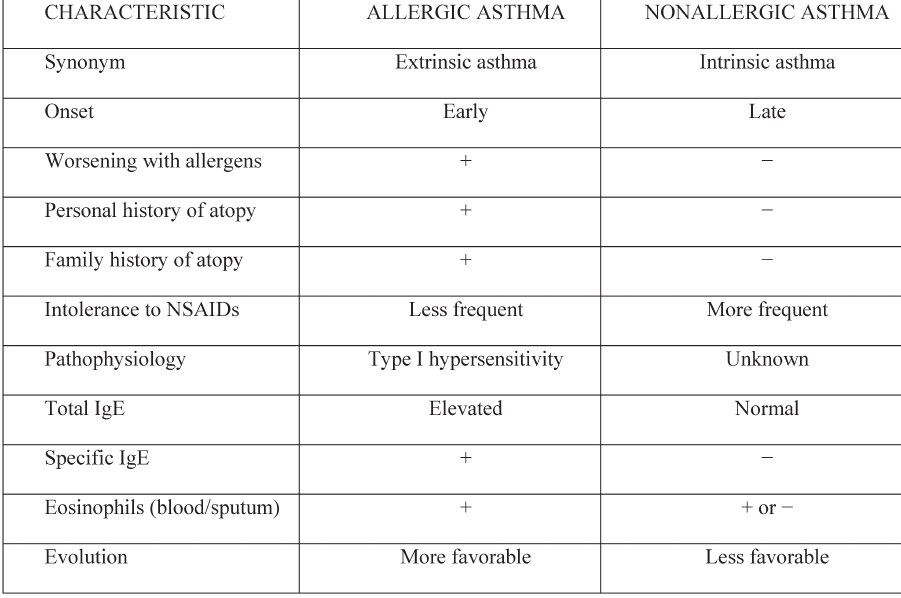
Figure 7 - Differences between allergic asthma and non-allergic asthma. NSAID: nonsteroidal anti-inflammatory drug; IgE: